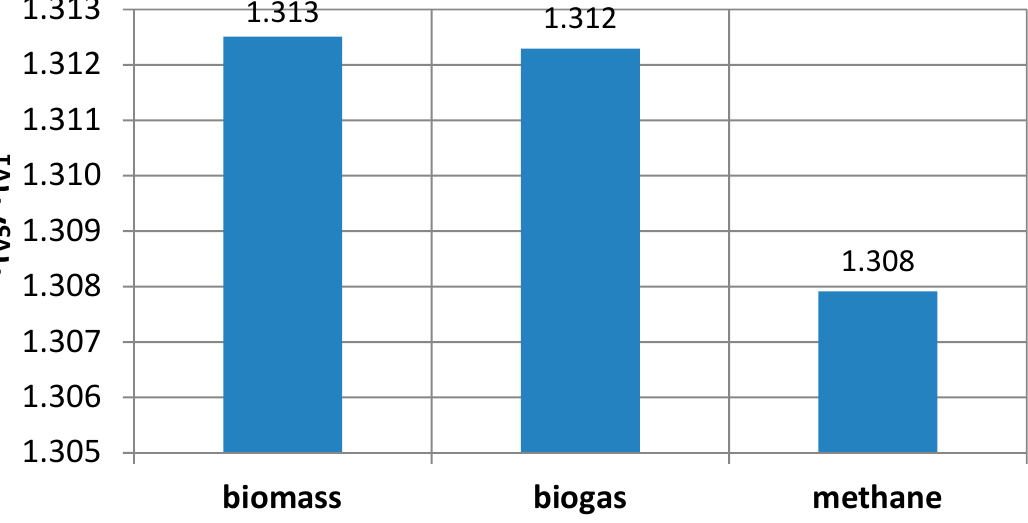
Figure 16. The effect of calorific value of fuel on the relative efficiency of the cycle with the external combustion chamber and bypass and additional steam circuit (V5) referred to the cycle with regenerator (V1).